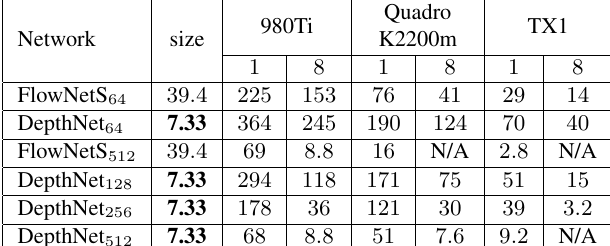
Figure 6. some results on 512x512 images